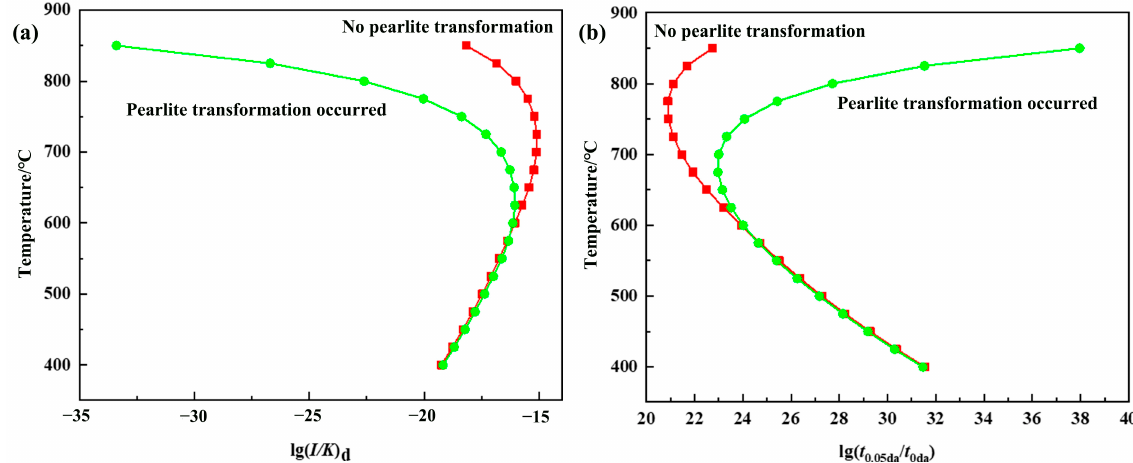
Figure 6. TiC precipitation in ferrite with NrT ( a ) and PTT ( b ) curves.